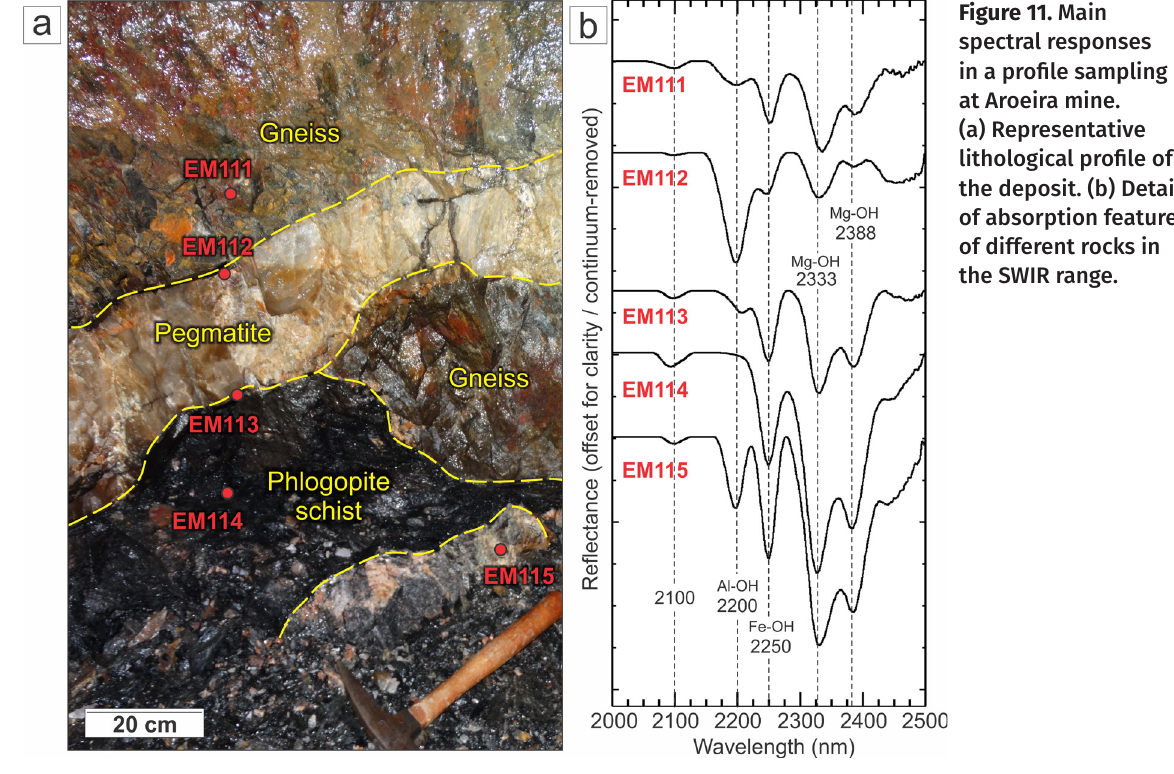
Figure 11. Main spectral responses in a profile sampling at Aroeira